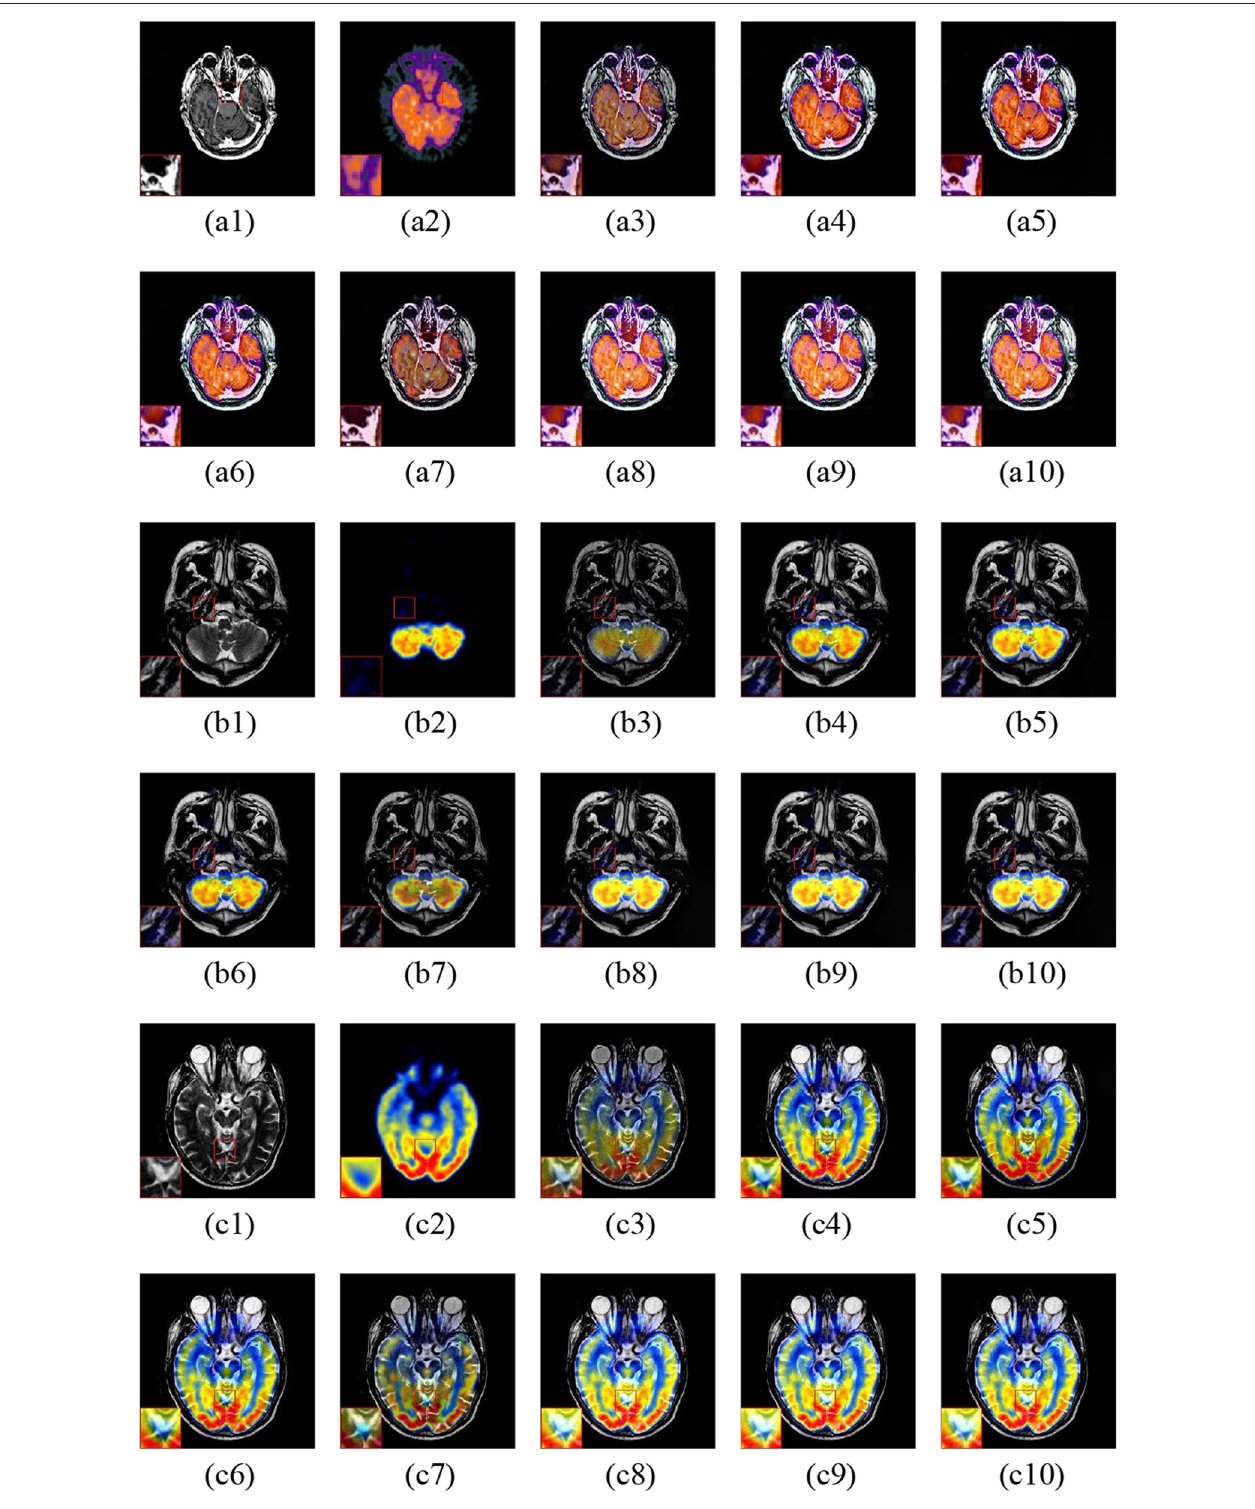
FIGURE 8 | Three fusion examples of MR and PET images. One close-up is provided in each set for better comparison. The original images: (a1–c1) MR and (a2–c2) PET. The fusion results: (a3–c3) ASR, (a4–c4) NSCT-PC-LLE, (a5–c5) LP-CNN, (a6–c6) NSST-PAPCNN, (a7–c7) CSMCA, (a8–c8) LatLRR-FCN-32s, (a9–c9) LatLRR-FCN-16s, and (a10–c10) LatLRR-FCN-8s.